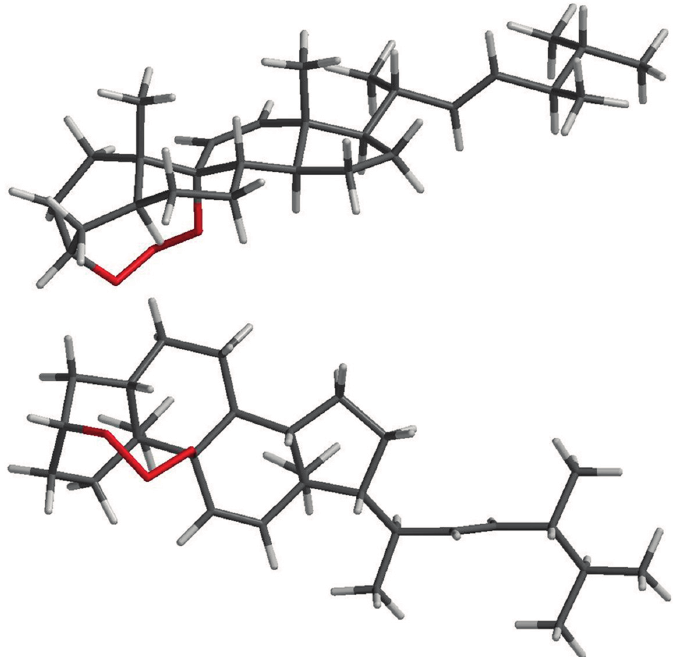
Figure 3. Perpendicular views of the 3D representation of LSDA/pBP86/DN* optimized structure of the 3,9-(1,2,3-trioxocine)-type steroid, compound 6